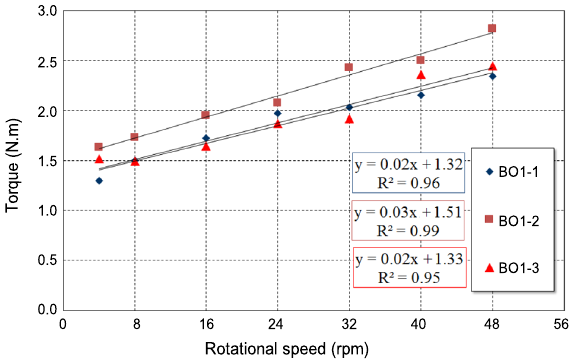
testFig. 14. Variation of torque at different rotational speeds for the repeatability test of the concrete Table 2. Comparison between the torques at the beginning and the end of the Concrete Full blade Hollow blade Blade in double U